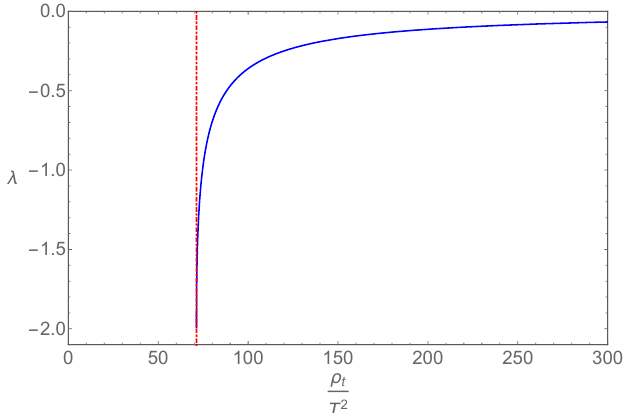
Figure 9 . The dependence of the turning point ρ t as a function of the parameter λ in the 0th order phase transition case. For an example, see the left panel of figure